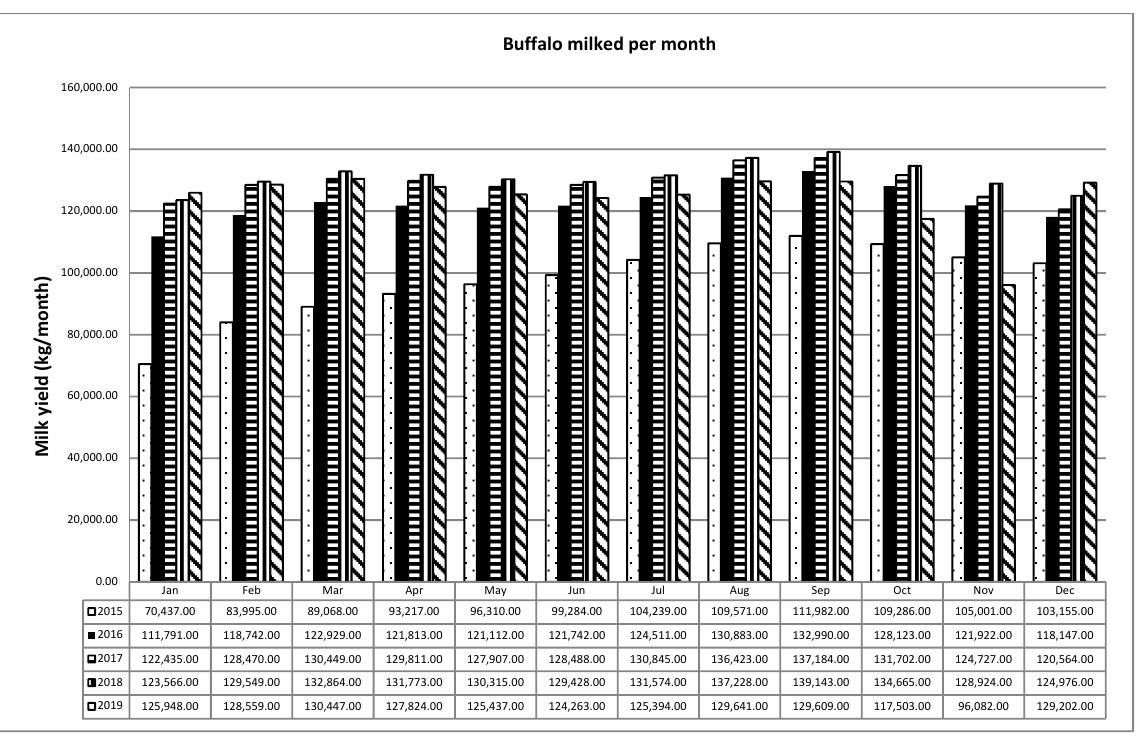
Figure 3. Buffalo milked per month.